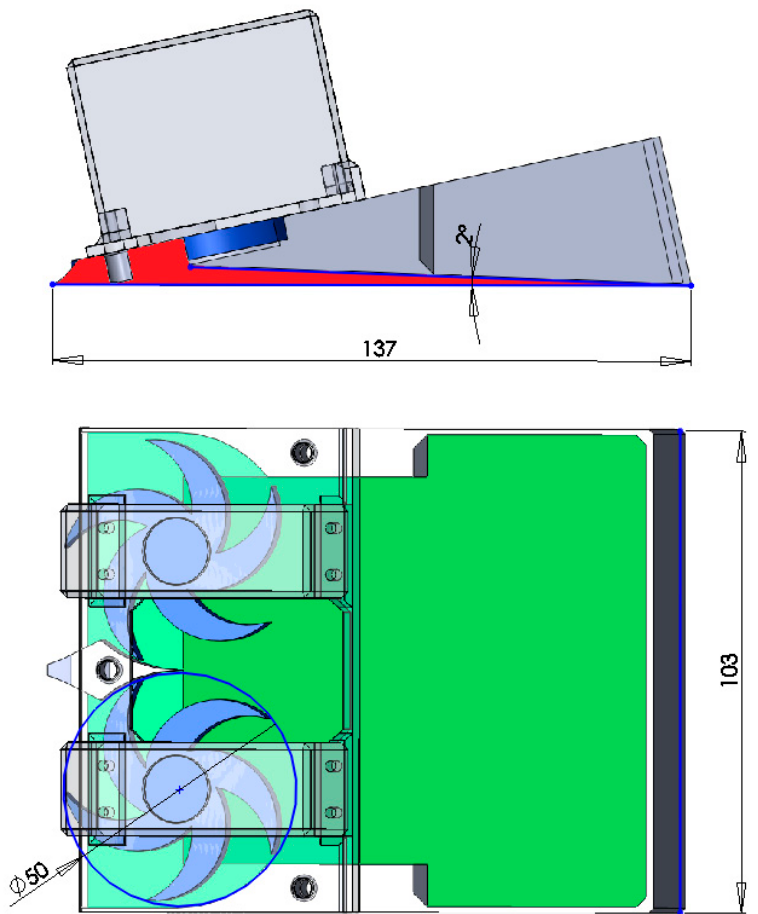
Figure 2. Hypothetical harvester dimensions (in mm).